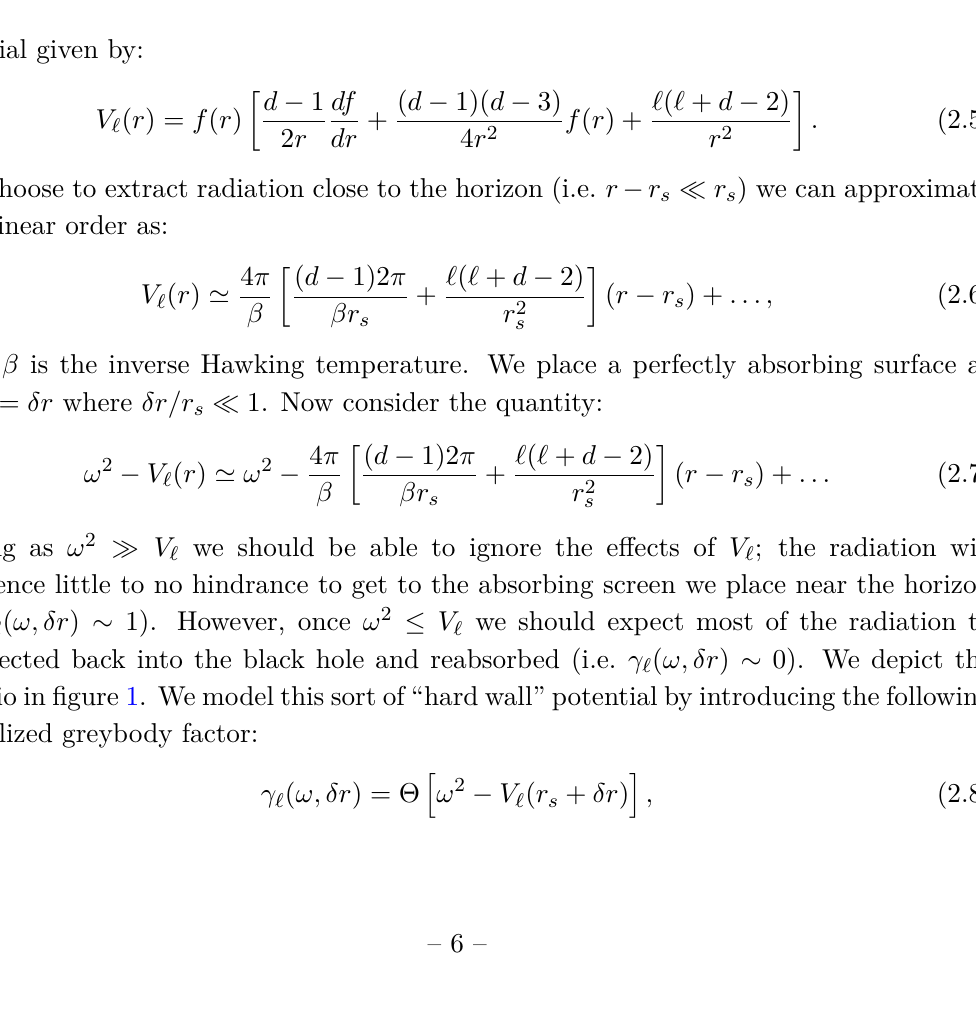
Figure 1 . Above is a depiction of how perturbations behave near the horizon with a generalized greybody factor given in eq. (2.8). Near the horizon the Potential V ‘ ( r ) is linear and is depicted by the solid blue line. The slope of the blue line increases with ‘ . The absorptive boundary is depicted by the vertical red line at r = r s + δr . The thick black line is a lower bound for the frequency of radiation that gets absorbed. Everything below the thick line has frequency p ω < ω min ,‘ = V ‘ ( r s + δr ) and cannot get to the absorbing surface, it bounces off the potential and gets reabsorbed. Everything above the thick line has frequency ω > ω min ,‘ and is able to reach the absorptive surface and gets completely